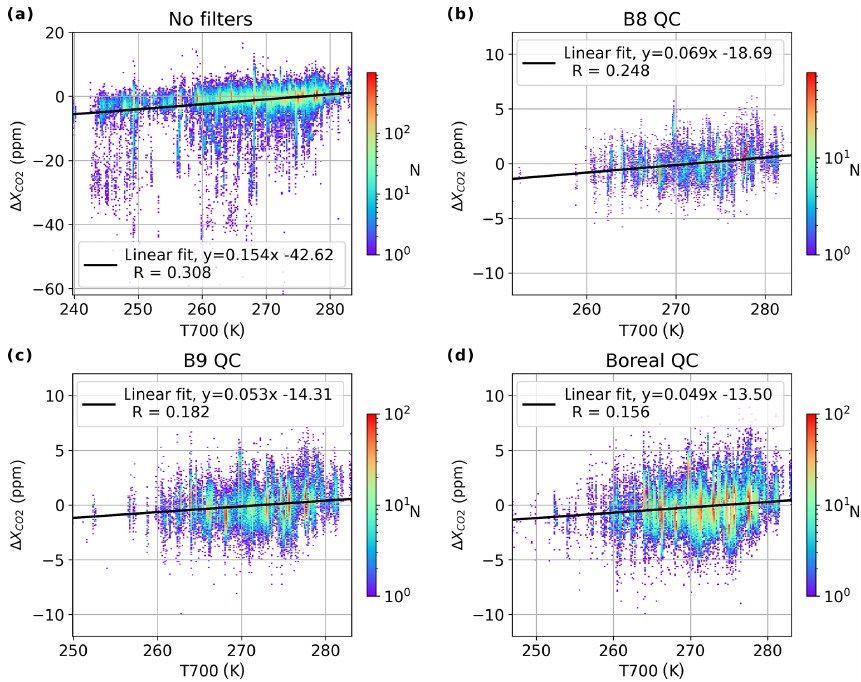
≡ OCO-2 – NNG) as a function of midtropospheric temperature (T700 ≡ temper- ( (cid:49)X CO 2 2